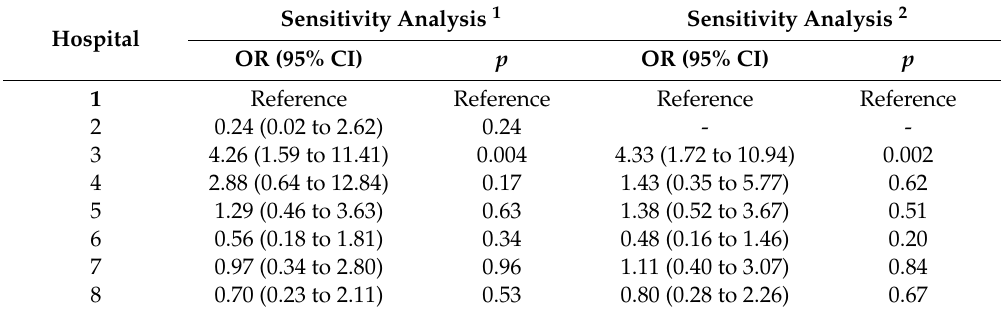
Table 2. Results of the sensitivity analyses with adjusted odds ratio (OR) and 95% confidence intervals (CI) for new nursing home placement according to hospital presented.